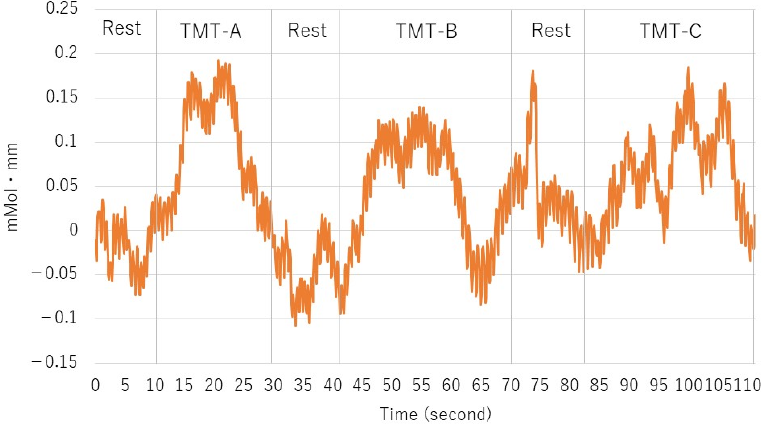
Figure 6. Data of HOT-2000. ( a ) first time, ( b ) second time, ( c ) third time, ( d ) fourth time.